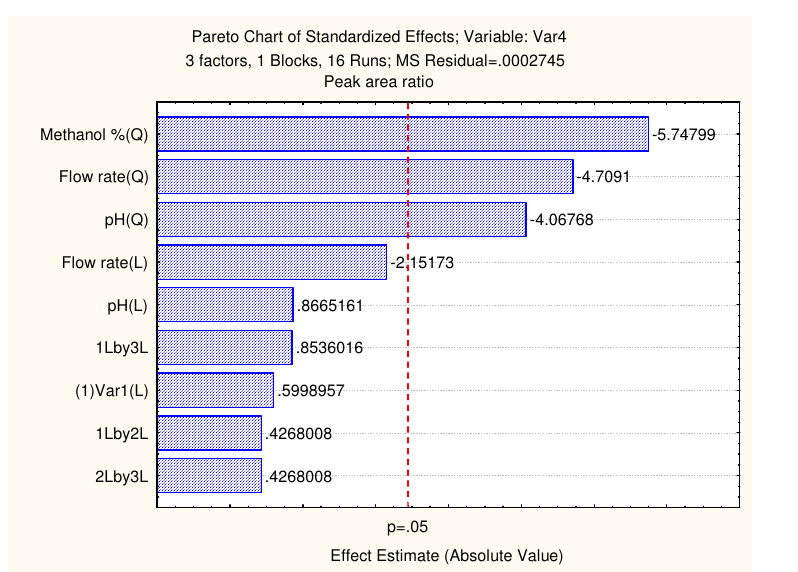
Figure 3. Pareto chart of standard effects : % Methol, Flow rate, pH and combination of these in decreasing order of significance for this method Table 5 . ANOVA results